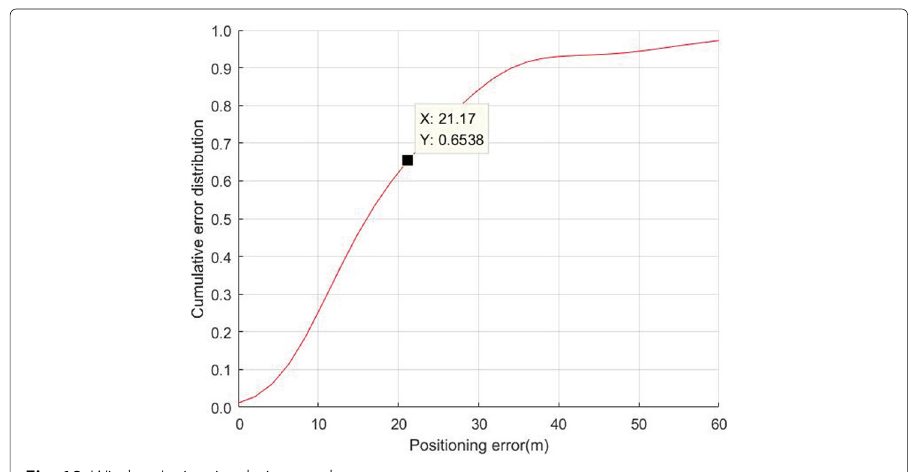
Fig. 18 Wireless Insite simulation